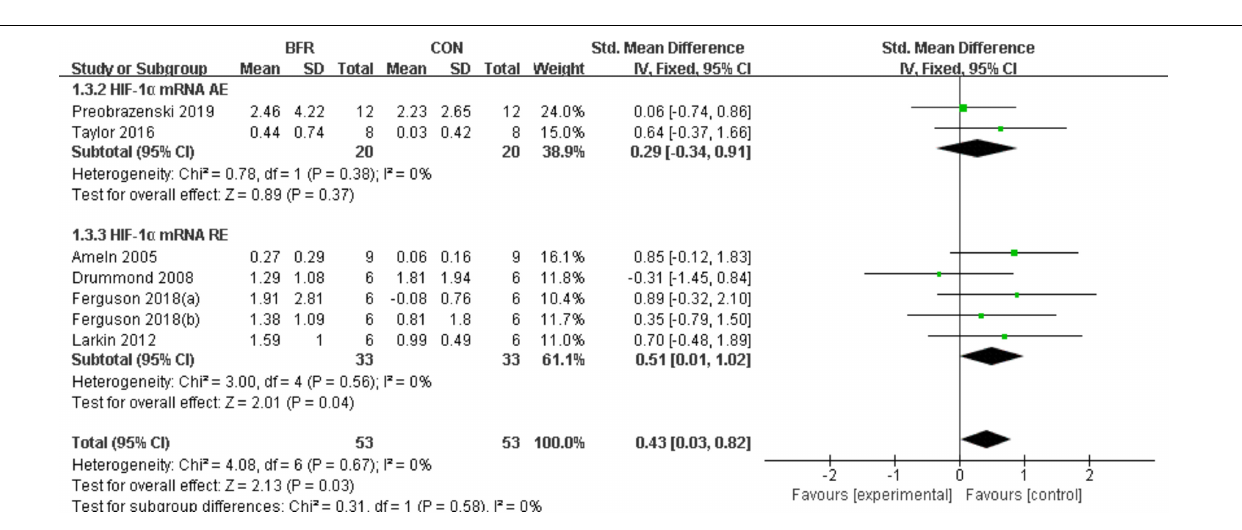
FIGURE 3 | The forest plot of the effect size for studies assessing the effect of blood flow restriction exercise on the HIF-1 α